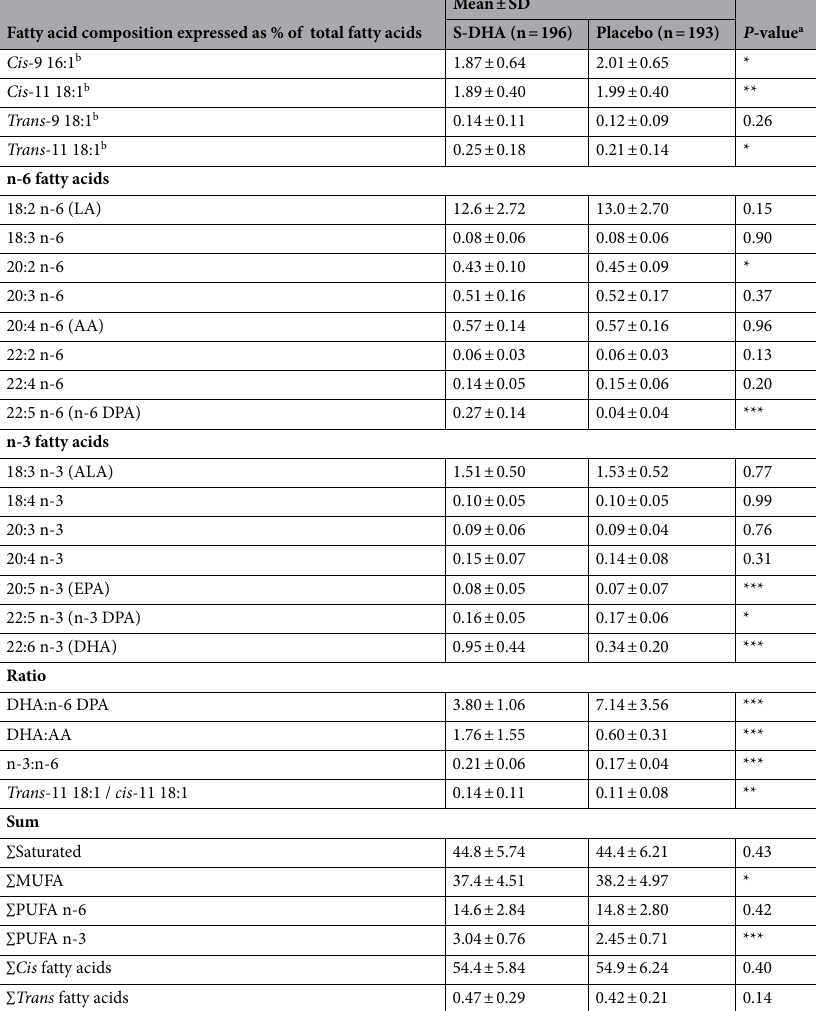
arachidonic acid, DPA docosapentaenoic acid, EPA eicosapentaenoic acid, DHA docosahexaenoic acid, MUFA monounsaturated fatty acid, PUFA polyunsaturated fatty acid. a Estimated by the